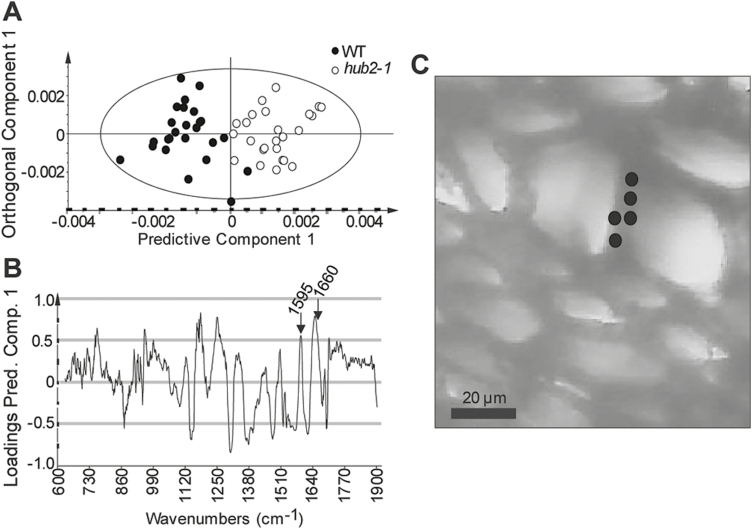
HUB2 alters the lignin properties of the xylem vessel secondary cell walls. (A, B) Raman microspectroscopic analysis of the secondary cell walls between two adjacent vessel elements in the secondary xylem of the hypocotyls in the hub2-1 mutant and WT. Spectra were collected from five 8-week-old plants per genotype, with at least two images per plant and five spectra per image. OPLS-DA model with 1 + 2 (predictive+orthogonal) components, n=50, R2X(cum)=0.848, R2Y(cum)=0.746, Q2(cum)=0.69. The Q2(cum) value stands for the predictive ability of the model, with higher values (closer to the maximum 1) generally meaning better separation for the same data set. (A) Scores plot showing the separation between hub2-1 (white symbols) and WT (black symbols) in the vessel–vessel walls. Each symbol represents one spectrum. (B) The corresponding correlation scaled loadings plot for the predictive component, showing factors separating the WT from hub2-1 in vessel elements. Bands on the negative side of the plot have higher relative intensity in the spectra of WT plants, whereas bands on the positive side have higher relative intensity in the spectra of hub2-1 plants. The bands corresponding to the aromatic -C=C- vibrations at 1595–1 and 1660 cm–1 (prominent bands associated with lignin) are marked by arrows. (C) White-light image of a representative transverse section analysed by Raman microspectroscopy. The circles show examples of locations extracted for spectra in cell walls between two adjacent vessel elements. The image is taken at ×50 magnification. The scale bar represents 20 µm.